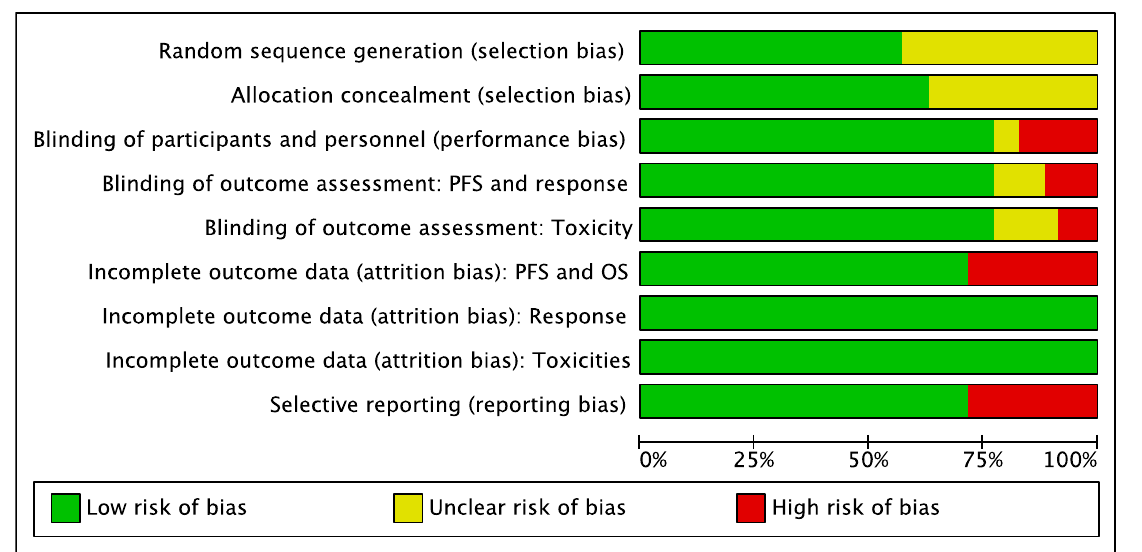
Figure 6. Risk of bias analysis.